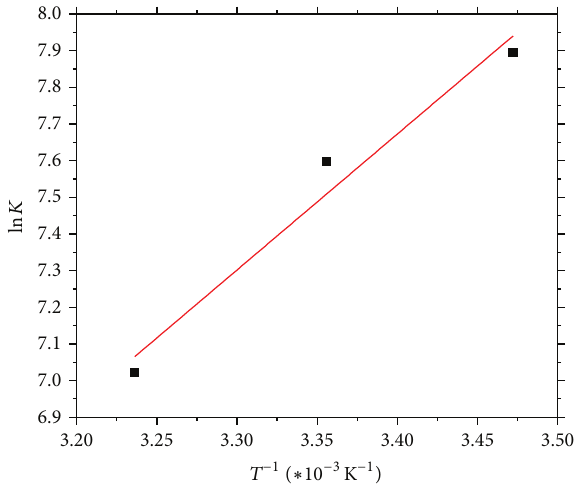
Figure 4: Van’t Hoff plot for the binding between EVG and BSA, variation of ln 𝐾 as a function of 1/𝑇 .